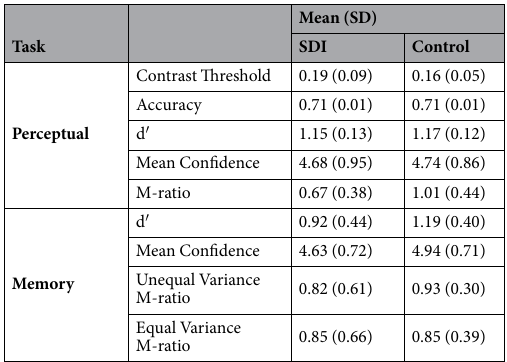
Table 1. Behavioral measures for the SDI and Control participants. Mean scores and Standard Deviation (SD) are